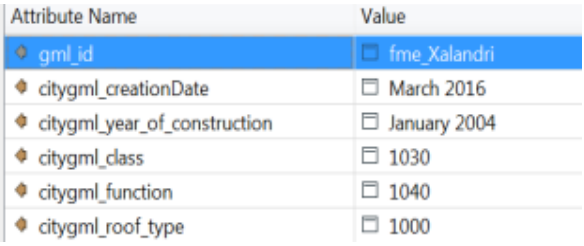
Figure 7: Addition of attributes in the model